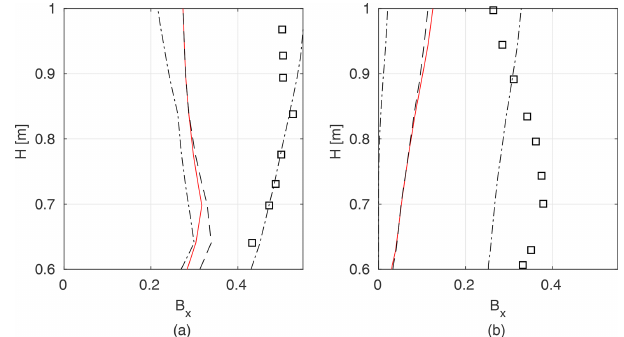
Figure 19. Blockage factor B X measured in the field and deter- mined as an inverse solution of GTLM for the Ritobacken autumn 2011 (a) and spring 2012 (b) case studies; squares denote measured values, dashed lines confidence intervals and the median of a proba- bilistic solution, and red line the best simulation in the Monte Carlo